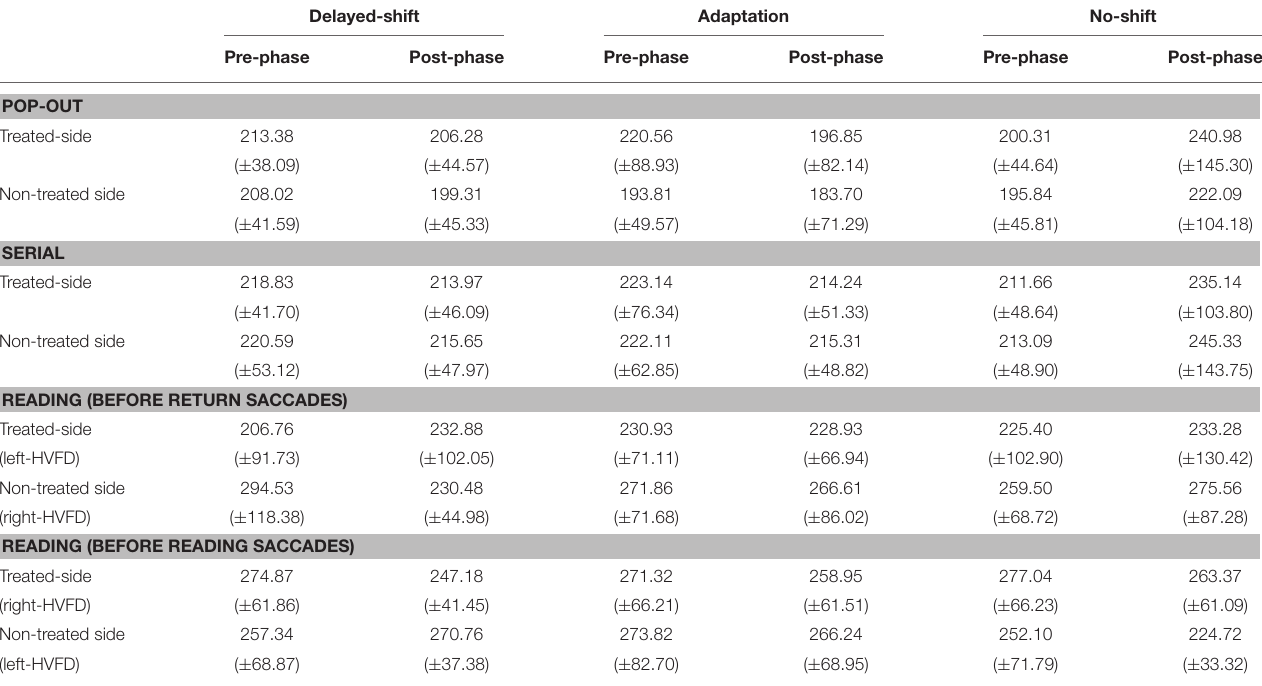
TABLE 3 | Mean fixation duration in ms ( ± SD) of the forthcoming saccades performed toward the treated- vs. non-treated side in visual exploration and reading